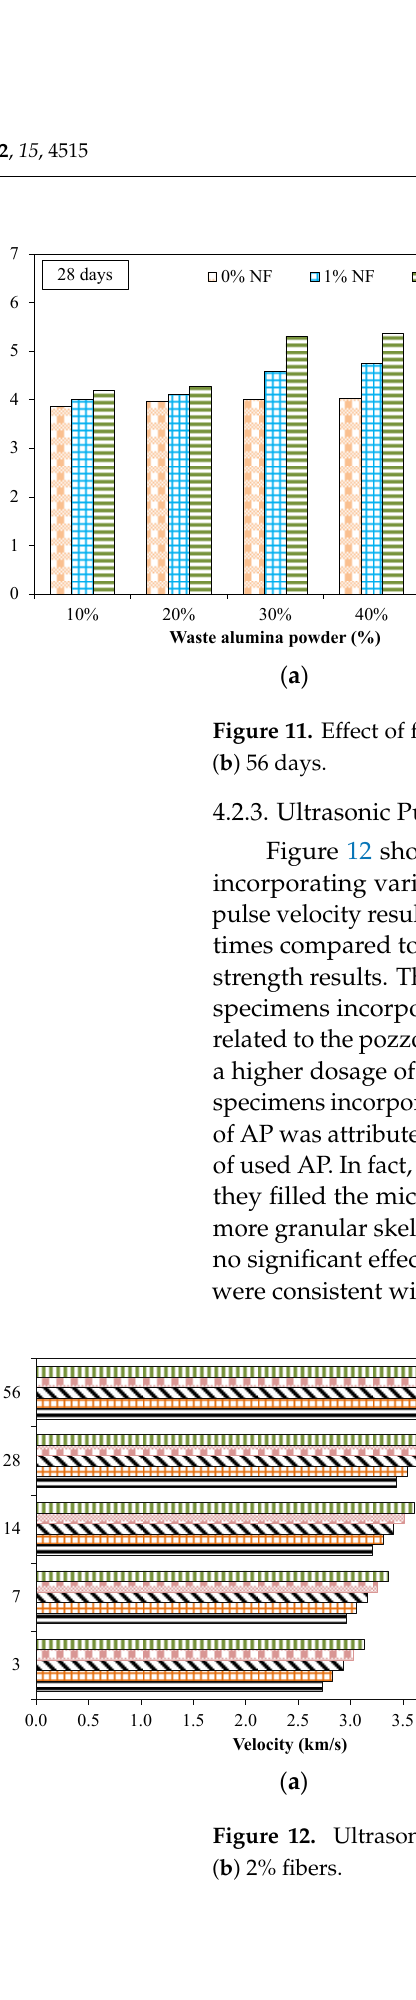
Figure 12. Ultrasonic pulse velocity test results for specimens incorporating AP. ( a ) 0% fibers ( b ) 2% fibers.